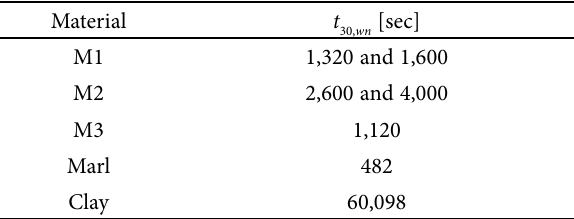
at natural water content 30